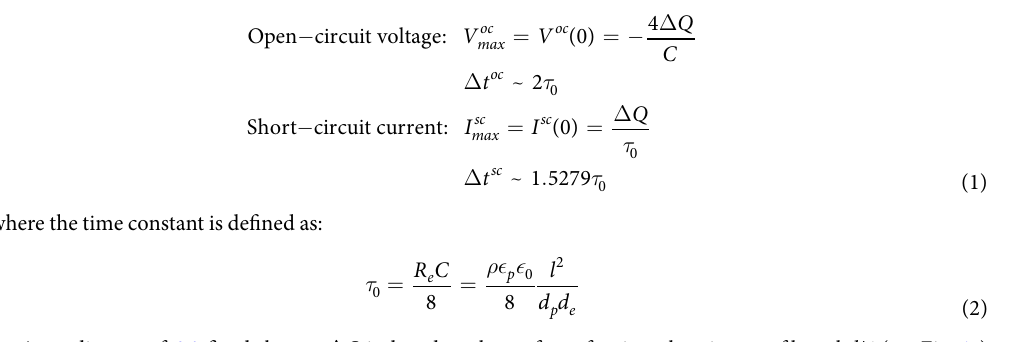
∆ Q 4 maxoc oc − = = − V V Open circuit voltage: (0) C oc ~ ∆ τ 2 t 0 ∆ Q maxsc sc − = = Short circuit current: (0) I I τ 0 sc ~ ∆ . τ 1 5279 (1) t 0 ρ 2  R C l 0 e p = = τ 0 d d 8 8 (2) p e